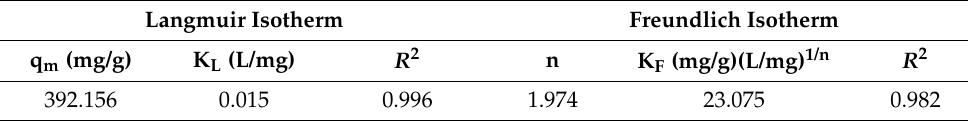
Table 1. Isotherm parameters for the adsorption of RO16 dye onto Cu(I)-PANI composite. Langmuir Isotherm